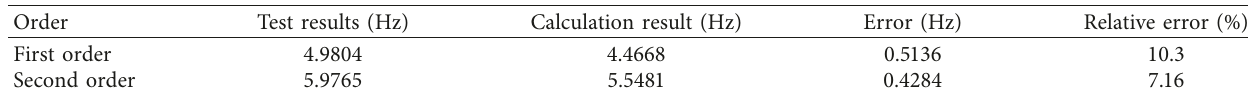
Figure 5: Self-vibration test system. Table 2: Comparison table of test results and calculation results.